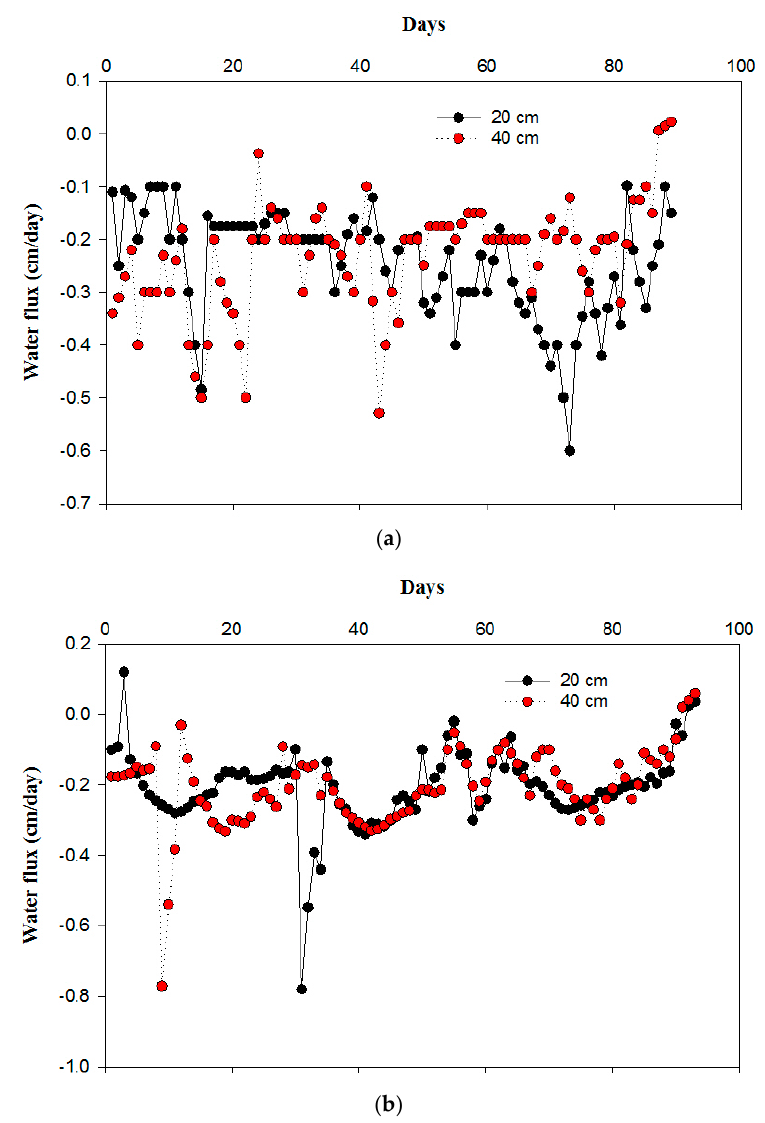
Figure 7. Simulated water fluxes within root zone (0–40 cm) during the ( a ) off-season and ( b ) main season.